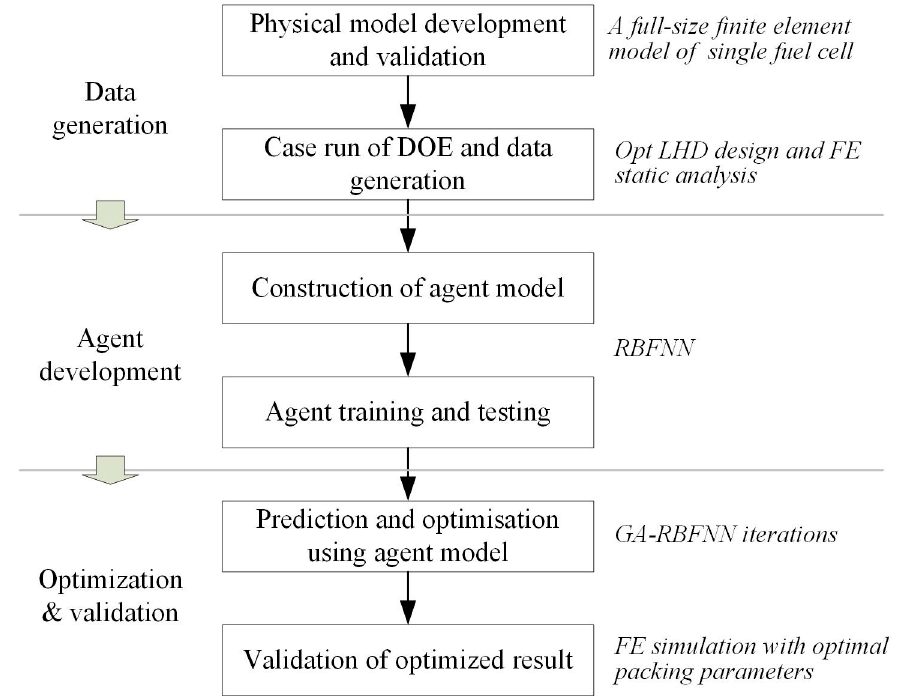
Figure 3. Framework of the intelligence-based prediction and optimization approach.